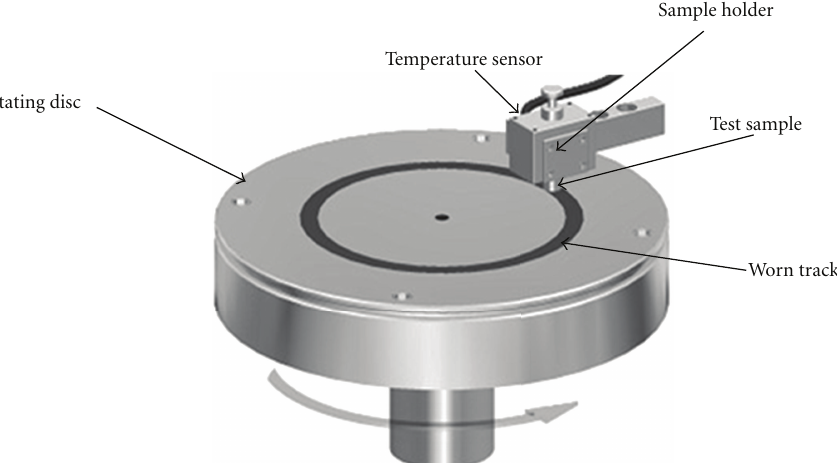
Figure 1: Schematic configuration of Pin-on-Disc machine employed for wear test.